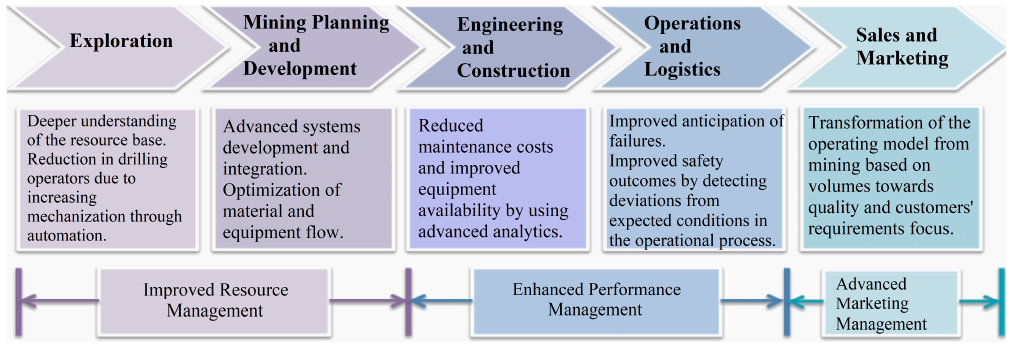
Figure 3. The impact of the digital technologies’ implementation on different stages of mining value chain (Reprinted from Ref. [26]).